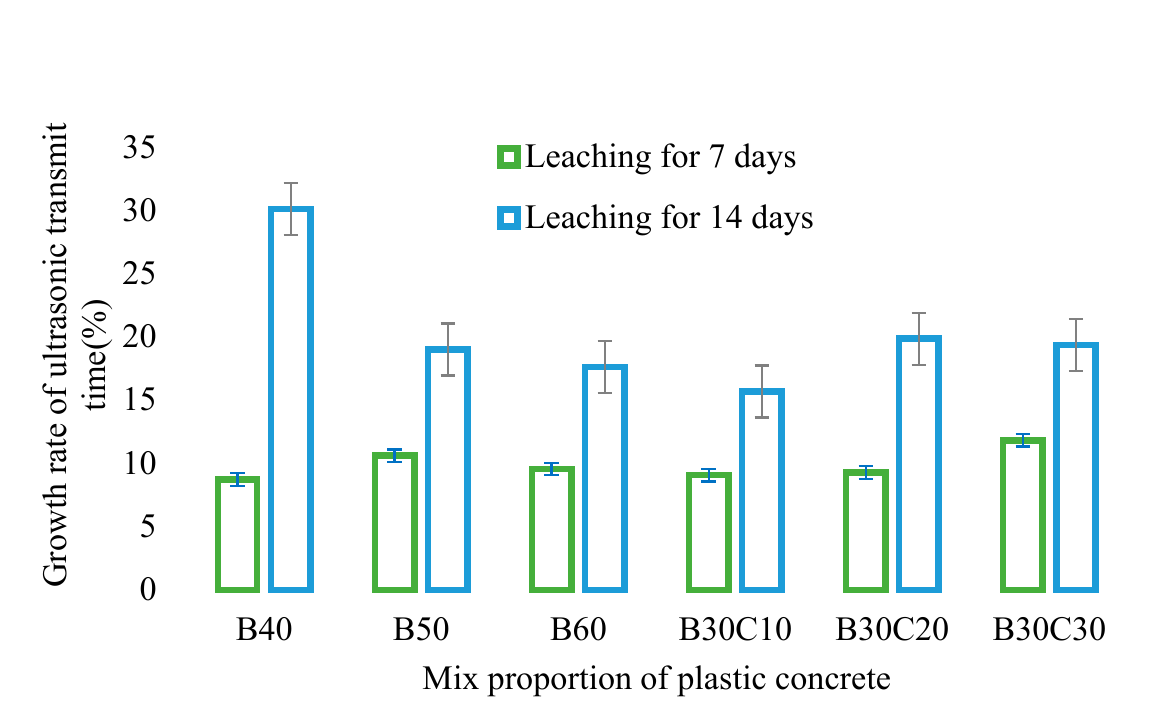
Figure 8. Effect of leaching on ultrasonic transmit time through the plastic concrete.